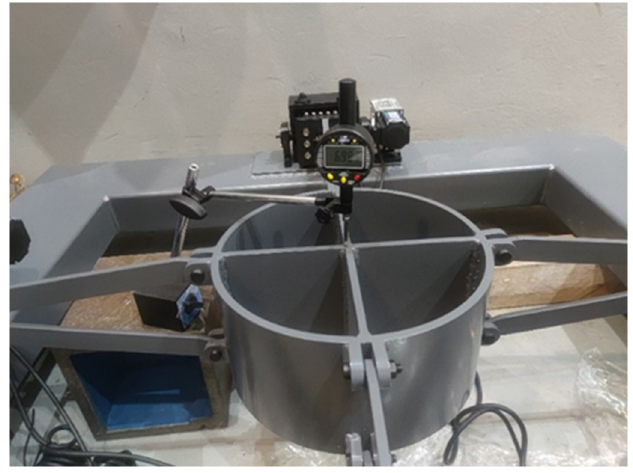
Appl. Sci. 2023 , 13 , x FOR PEER REVIEW Figure 10. z-directional resolution test. Figure 10. z-directional resolution test.